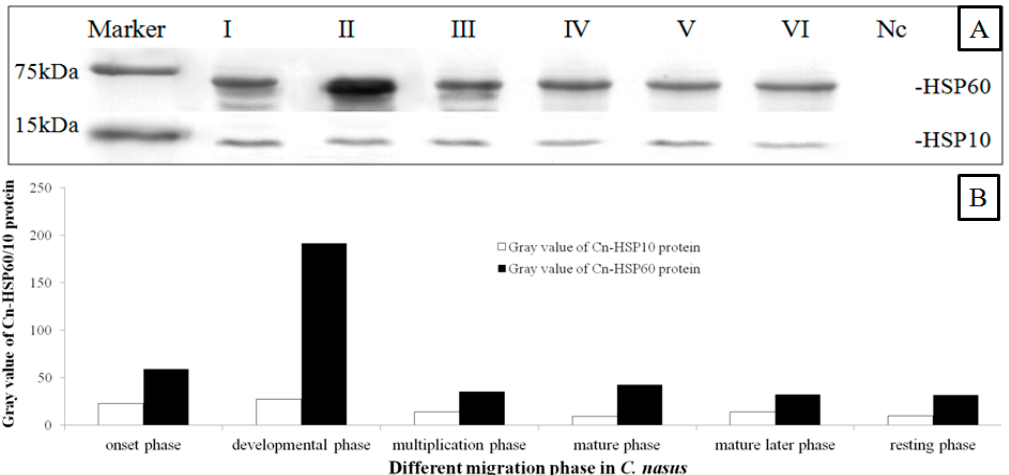
Figure 4. HSP60 and HSP10 protein expression patterns in different migration phases. Three fish in the different developmental phases were used for western blot (WB). The crude protein extract of adult Coilia nasus testes were pooled and then the WB was done as described. Marker; I: onset phase; II: developmental phase; III: multiplication phase; IV: mature phase; V: mature later phase; VI: resting phase; Nc: Negative Control. ( A ): HSP60 and HSP10 protein expression patterns in different migration phase; ( B ): The results were semi-quantitated analyzed by ImageJ2x 2.1 program. The expression level of HSP60 was considerately higher than the level of HSP10. HSP60 level reached the peak in the developmental phase. With the testes maturing, both proteins presented declining.